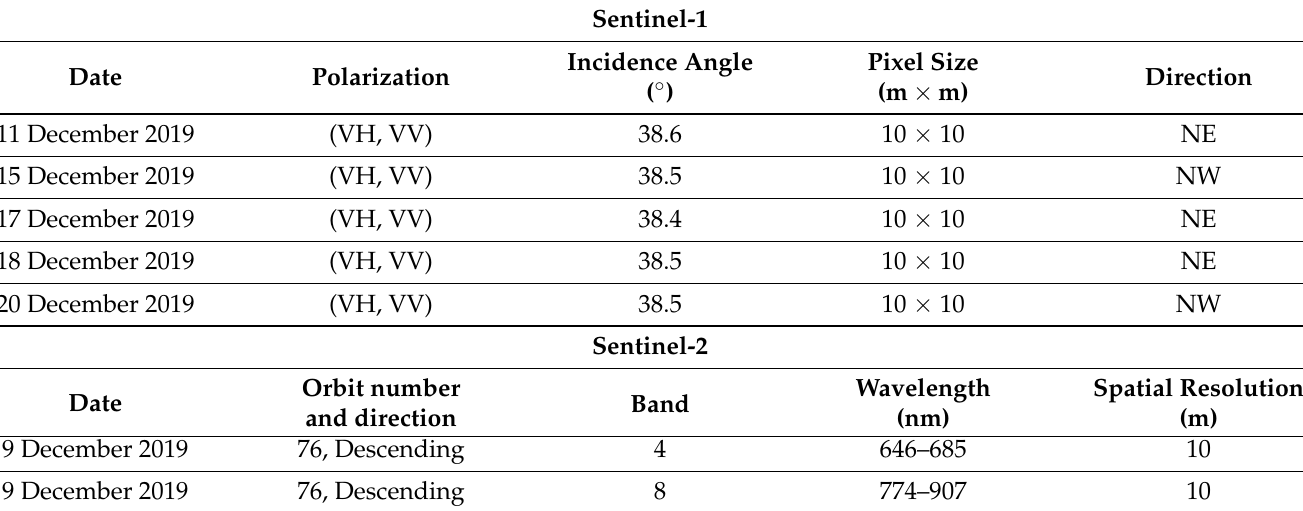
Table 1. Detailed specifications of Sentinel-1 and 2